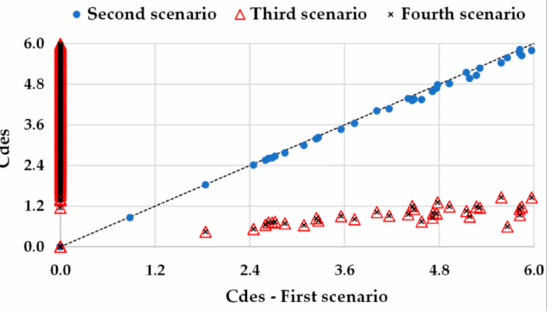
Figure 9. Sliding safety coefficients for the first scenario compared with the second to fourth